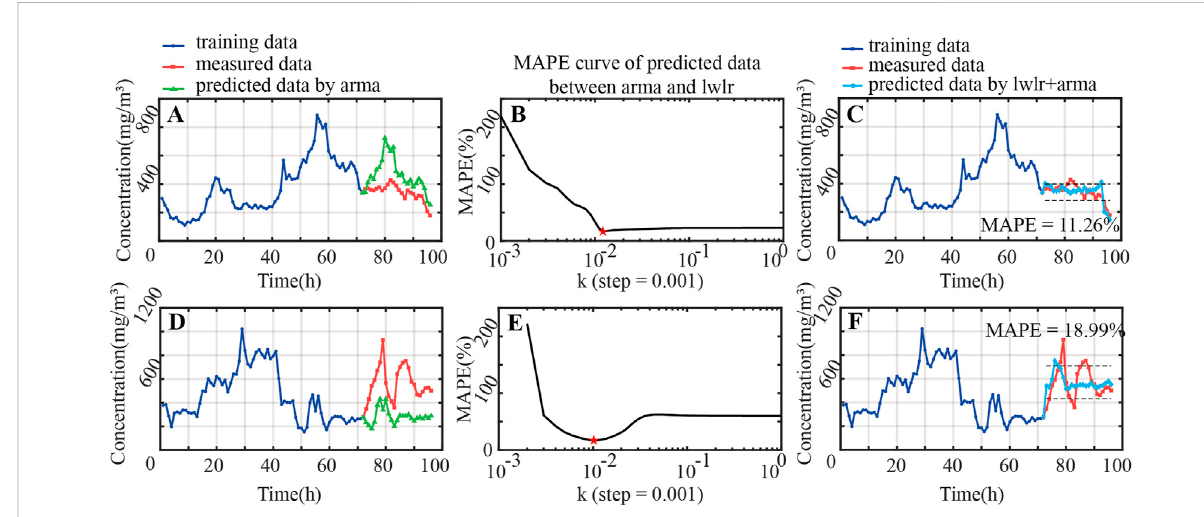
FIGURE 8 Comparison of measured concentrations and predicted concentrations based on the ARMA & LWLR method (K and Fe). (A,D) show the results before and after prediction by arma of K and Fe, respectively; (B,E) show the process of fi nding the most suitable parameter k of K and Fe, respectively; (C,F) show the results before and after prediction by lwlr + arma of K and Fe, respectively.